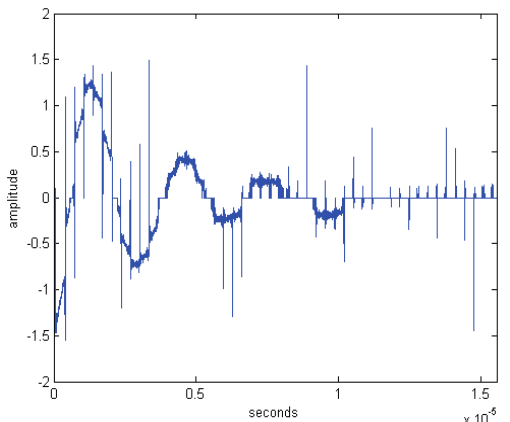
Figure 19. Simulation result of phase